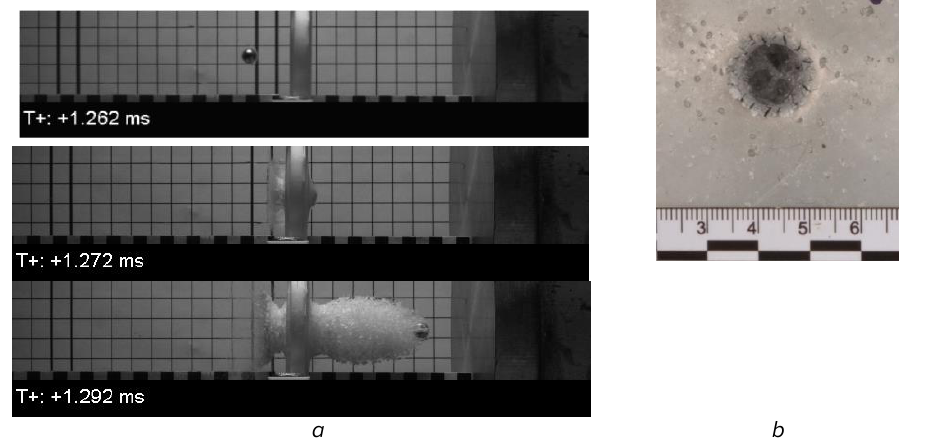
a b Fig 8. The photographic record of the plexiglass penetration ( a ), and the front of the barrier-“witness” ( b ) at V 0 = 2441 m/s